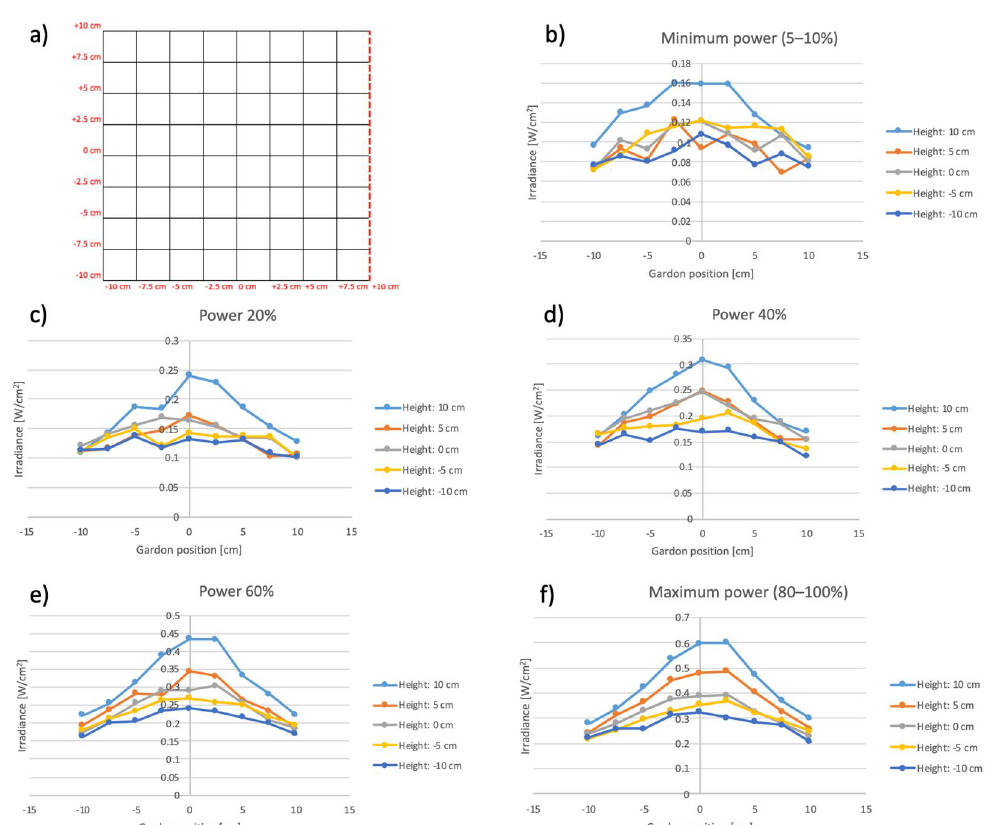
Figure 16. Irradiance along the horizontal line (+10 cm) highlighted in ( a ), for several heights of the workbench; all graphs are related to the lamp #7; ( b ) electrical power of lamp 5–10%; ( c ) electrical power of lamp 20%; ( d ) electrical power of lamp 40%; ( e ) electrical power of lamp 60%; ( f ) electrical power of lamp 80–100%.